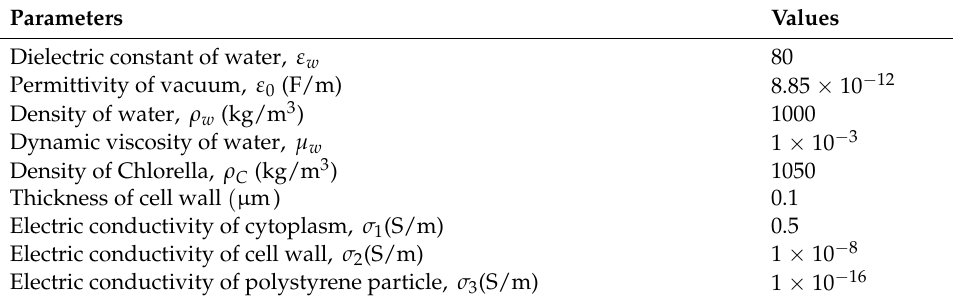
Table 1. Values of parameters utilized in the numerical study.